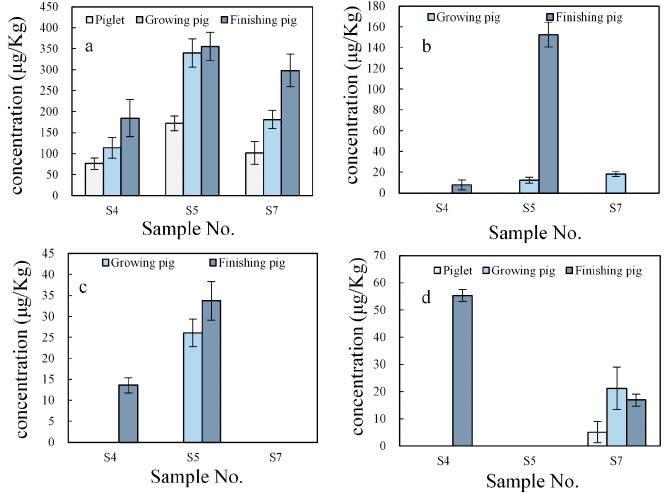
Figure 3. Concentrations of E3 ( a ), 17 β -E2 ( b ), BPA ( c ), and EE2 ( d ) in swine at different instars: piglets (body weights less than 20 kg); growing pig (body weights from 25 kg to 45 kg); and finishing pigs (body weights higher than 45 kg). S4, S5, and S7 represent farm numbers.